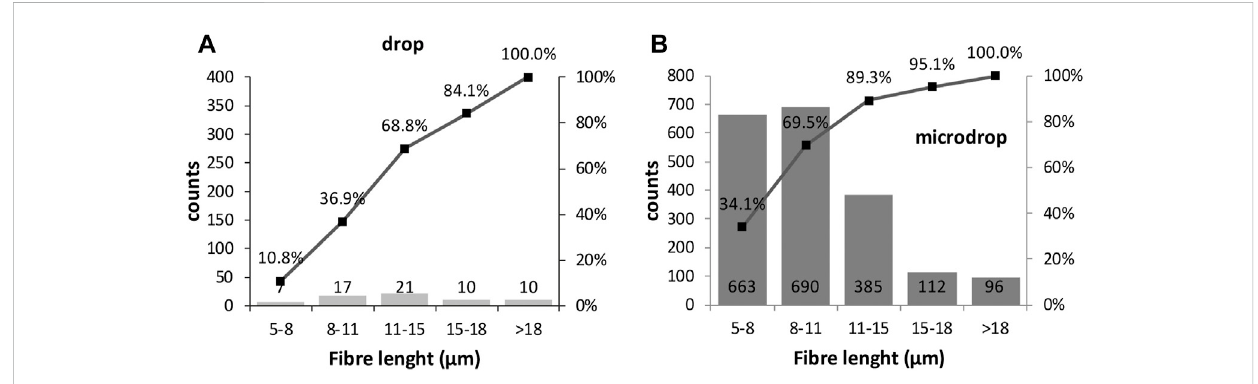
FIGURE 10 Histograms showing the length size distributions of the manually annotated fi bres (see text for explanation) in (A) drop and (B) micro-drop depositions in SEM images. Counts are normalised to 1 mm 2